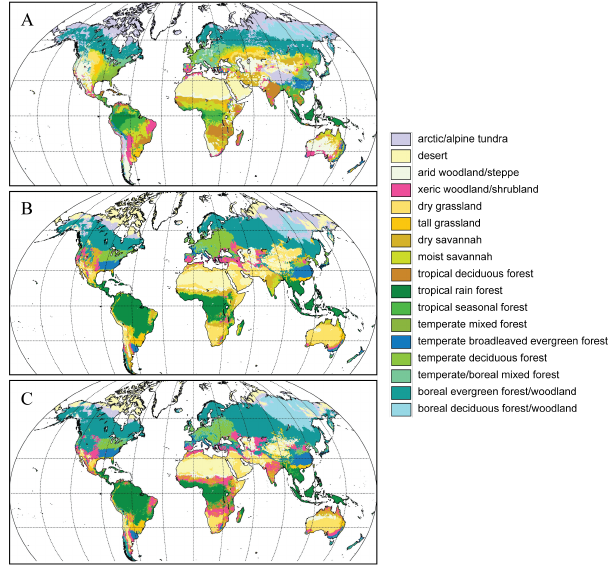
Fig. 2. Potential natural (Haxeltine and Prentice, 1996b; Hickler et al., 2006) (A) and simulated vegetation for 1961–1990 from the (B) C–N and (C) C-only simulations. The classification scheme for transforming PFT abundances from the model simulation to the vegetation classes (biomes) in the legend modified from Hickler et al. (2006) (see Appendix A, Table